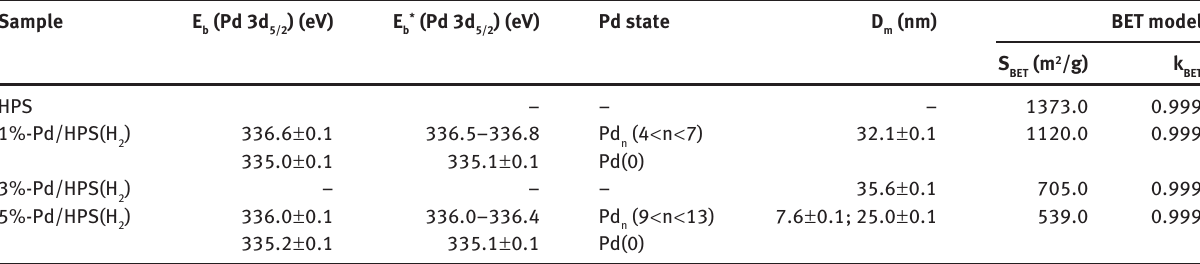
Table 3 Summary of the results of physicochemical characterization of HPS-based catalysts.